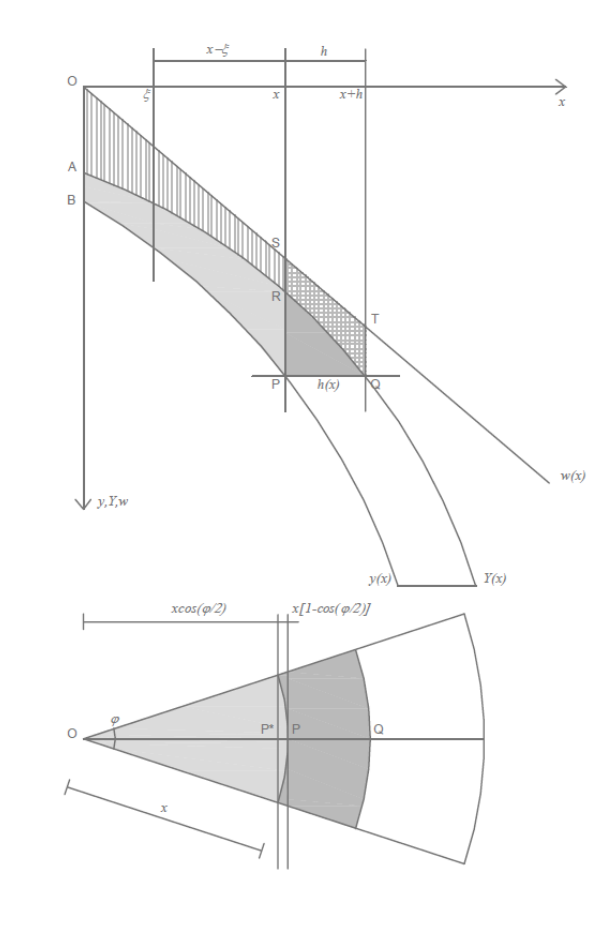
Figure 4: Finite dimension meridian wedge in plan and section, con- tributions to the stabilizing moment and the overturning moment of the self-weight and